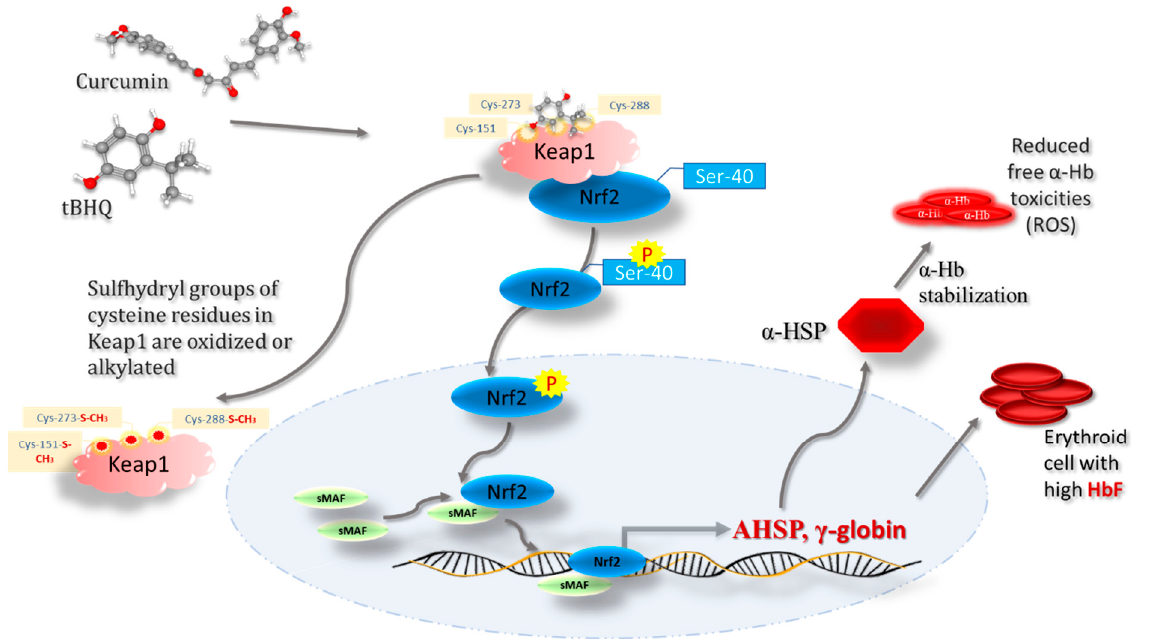
Figure 4. Since the Keap1–Nrf2 interaction is the most crucial part of this signaling, and for Nrf2 to play a cytoprotective role, it must be dissociated from Keap1 in response to oxidative stress. Various (natural and synthetic) molecules involved in Keap1–Nrf2 dissociation have been proposed because of their electrophilic properties. These molecules directly interact with some specific cysteine residues on Keap1; as a result, sulfhydryl groups on cysteines are either oxidized or alkylated (only alkylation is illustrated in the figure), leading to Nef2 dissociation from Keap1. It is also reported that tBHQ/curcumin phosphorylate Nrf2 at Serine-40. Subsequently, Nrf2 translocates to the nu-